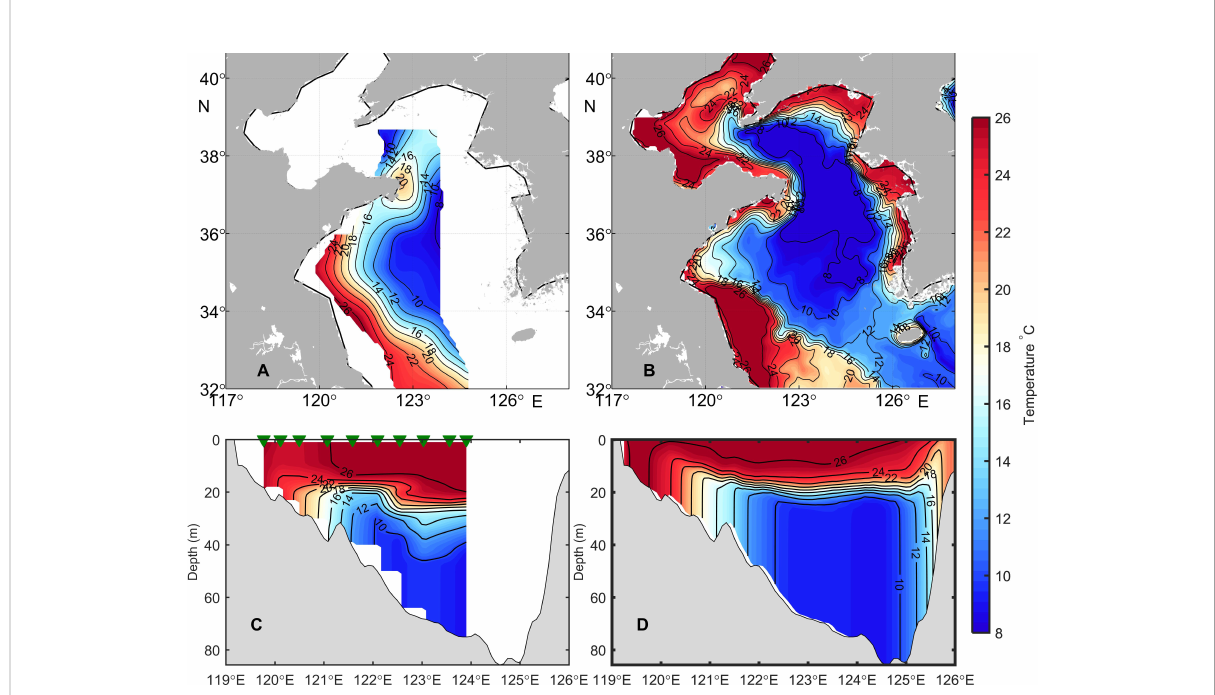
FIGURE 2 Bottom temperature distribution of in situ observations (A) and monthly mean model results (B) in August 2015. Temperature distributions of in situ observations (C) and monthly mean model results (D) at the 35°N section in August 2015. The triangles in (C) denote the conductivity- temperature-depth stations.